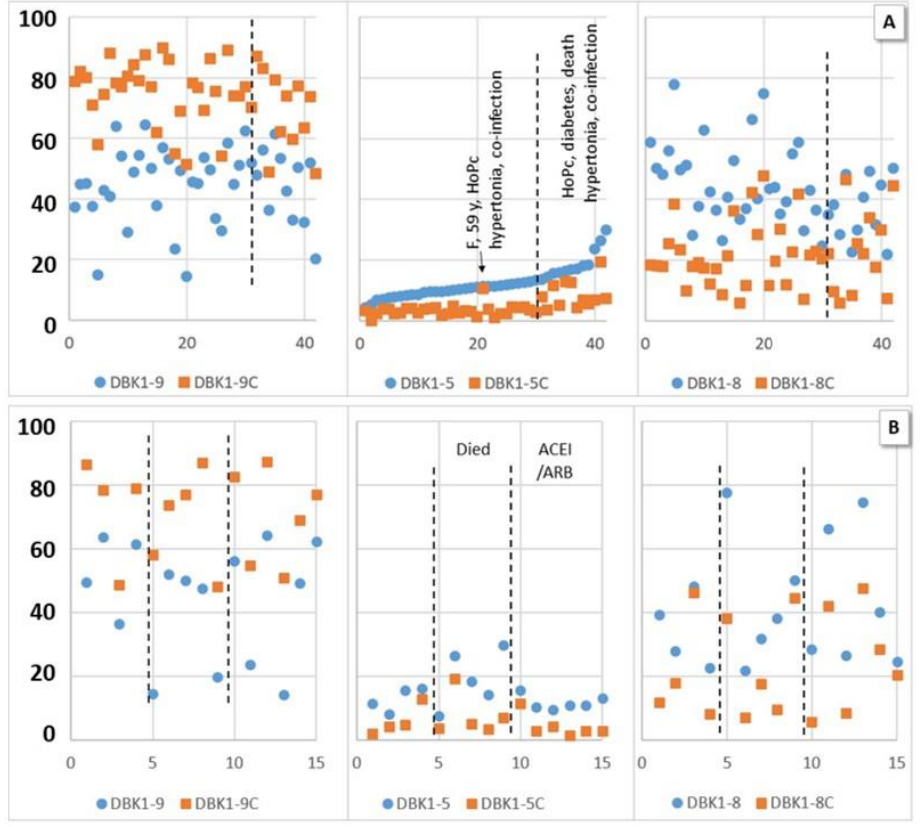
Figure 4. Experimental values (dabsylated bradykinin DBK1-9 and its fragments DBK1-8 and DBK1-5) in percent (y-axis; x-axis, random numbers) with inhibition by captopril (DBK1-9/8/5C, orange squares) and without inhibition (blue dots) for hospitalized patients (HoP). A ) Sorted by DBK1-5. High values of DBK1-5 and a lower effect of captopril were associated with other diseases in addi- tion to COVID-19 (diabetes, hypertonia, co-infection) and poor outcome (acute respiratory distress syndrome (ARDS), death) with one outlier (female (F)). B ) Hypertonic male patients, data ordered by ACEI/ARB (angiotensin-converting enzyme inhibitor/angiotensin receptor blocker) medication and fatality. High DBK1-5 was observed in critical patients, while patients on ACEI/ARBs showed balanced DBK1-5 values. No effect was seen for DBK1-9 and DBK1-8. No significant correlation of NRA data between hypertonic or non-hypertonic pa- tients, those taking or not taking ACEI/ARB, HoPs or HoPm, and those with fatal or non- fatal outcome was detected. However, when co-morbidities such as diabetes, hypertonia, melanoma and co- infection were summarized as a separate category called “other dis- ease”, DBK1 -5 and DBK1-5C differed significantly in the patient cohort (HoP; DBK1-5: T (40) = − 2.286, p = 0.028, d = − 0.74; DBK1-5C: T (49) = − 2.256, p = 0.030, d = − 0.73). Those values were also significantly different for the co-infected vs. the non-co-infected patients ( p = 0.004/0.001). DBK1-5C distinguished critical patients from the others (HoPc vs. HoPs: p = 0.03; vs. HoPm: p = 0.033). Interestingly, the least afflicted patients, those breathing normally (HoPm), differed significantly in DBK1-9Diff. Hospitalized patients (HoP) var- ied significantly (mostly at the p < 0.001 level) from recovered patients (CoP-NV) in DBK1- 9, DBK1-8 and all differences to the value after inhibition including DBK1-5Diff. Signifi- cant also was the difference in subgroups (HoP vs. CoP-NV: no inhibitor, alive, HoPm, HoPs, no hypertonia, no other disease). DBK1-5 was significantly different in the compar- ison CoP-NV vs. subgroups HoPs ( p = 0,002) and “no other disease” ( p = 0.008); DBK1-5C vs. subgroups co-infection ( p = 0.012) and HoPc ( p = 0.034) with CoP-NV.